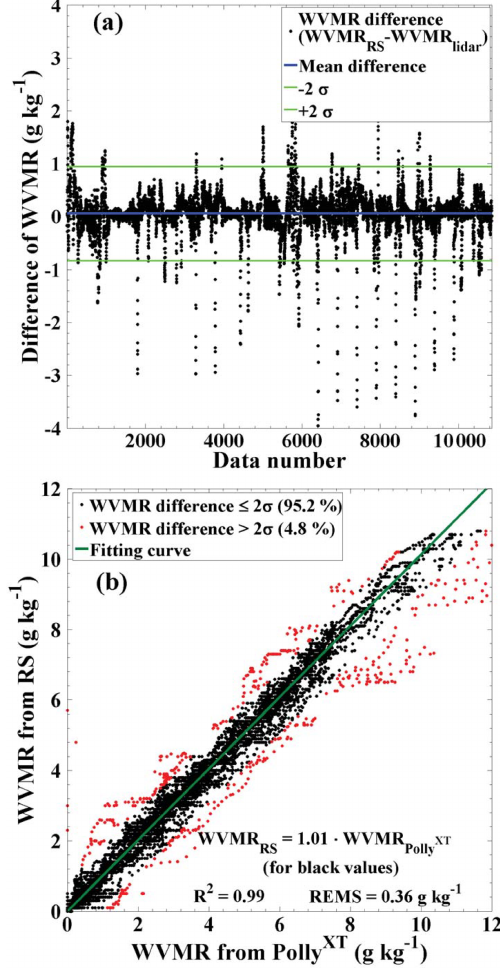
Figure 10. (a) Differences between radiosonde and lidar-retrieved water vapor mixing ratios and (b) scatter diagram of lidar WVMR versus radiosonde (RS) WVMR values. All of the 19 simultane- ous nighttime measurements with lidar and radiosonde are used. All profile values of the water vapor mixing ratio values between 30m and 8km are